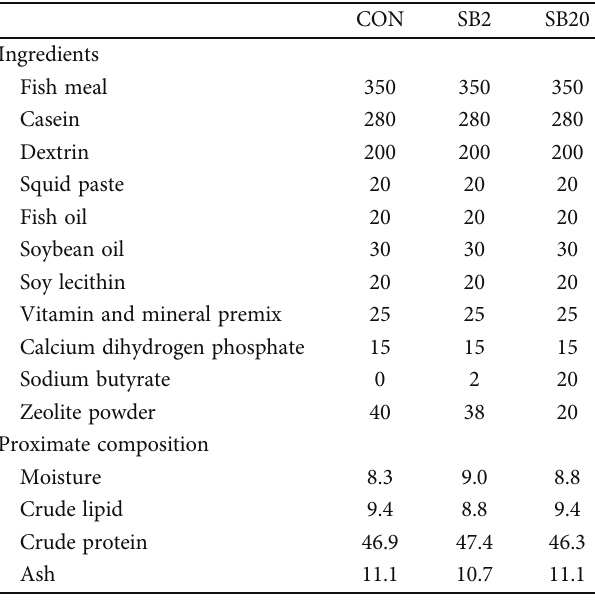
Table 1: Formulation and proximate composition of the experimental diets (g/kg, air dry